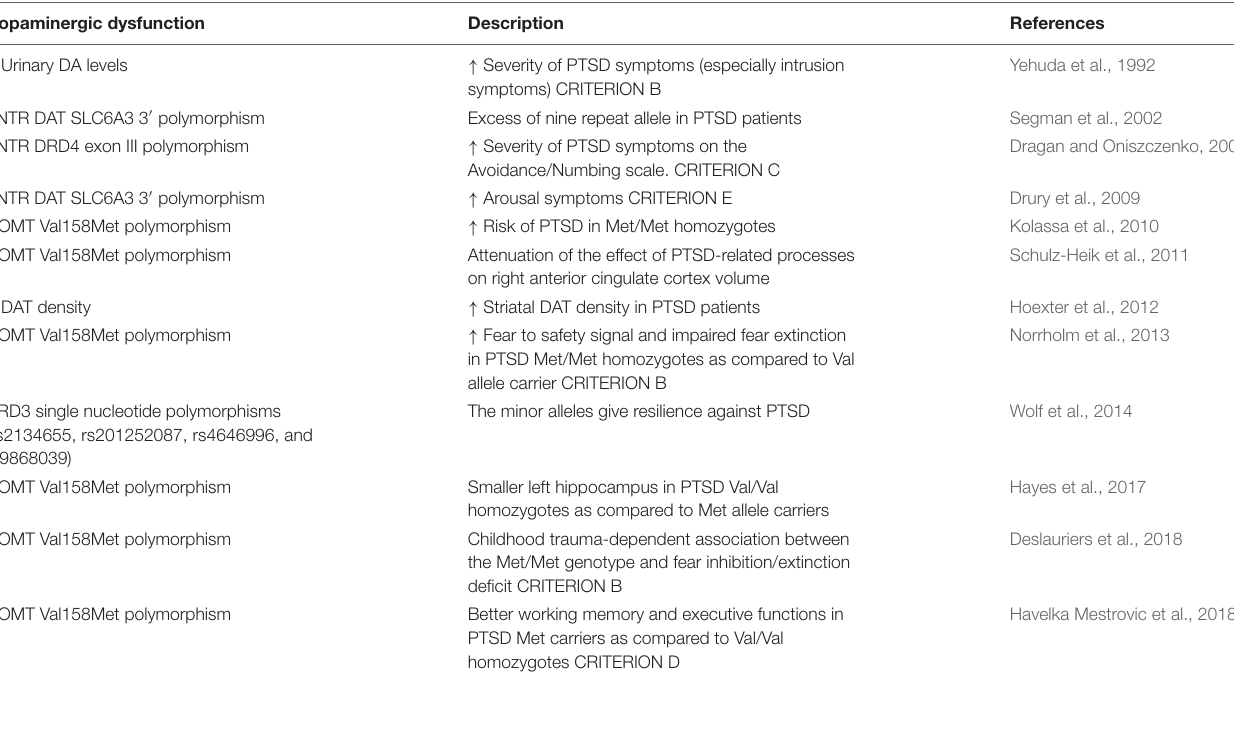
TABLE 1 | Findings from human studies demonstrating an impact of DAergic dysfunction on